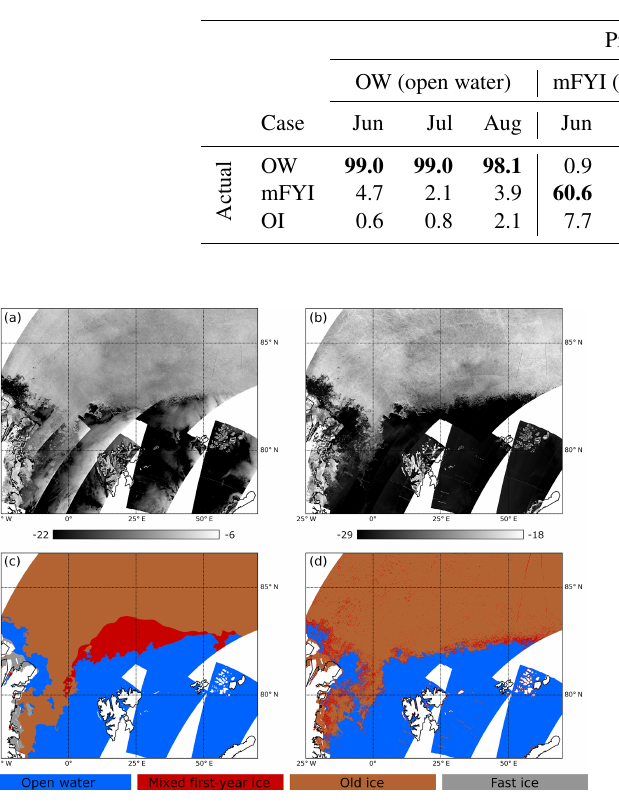
microwave radiometers (SSMIS and AMSR2) and backscat- ter values of radar scatterometer (ASCAT), using a Bayesian approach (Aaboe et al., 2018).